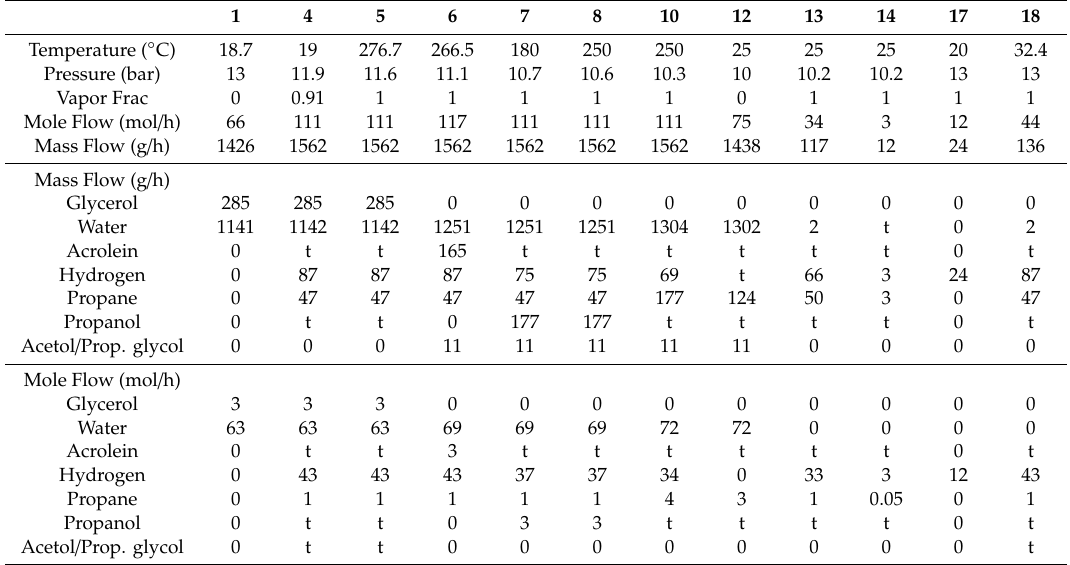
Table 1. Results from the heat and mass balance calculations, normal operation, t indicates traces 1